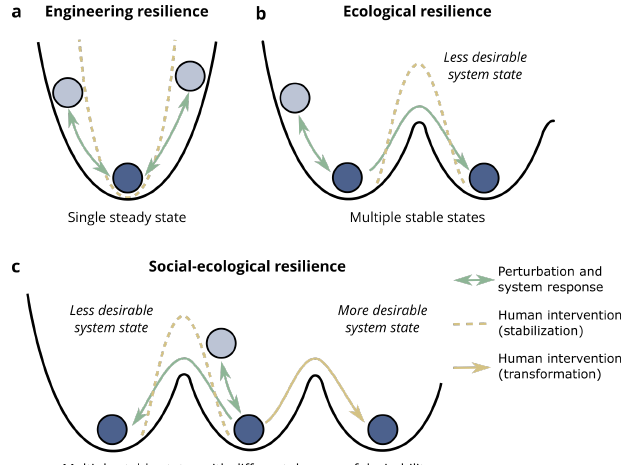
Fig. 1 . Different approaches of systems resilience: